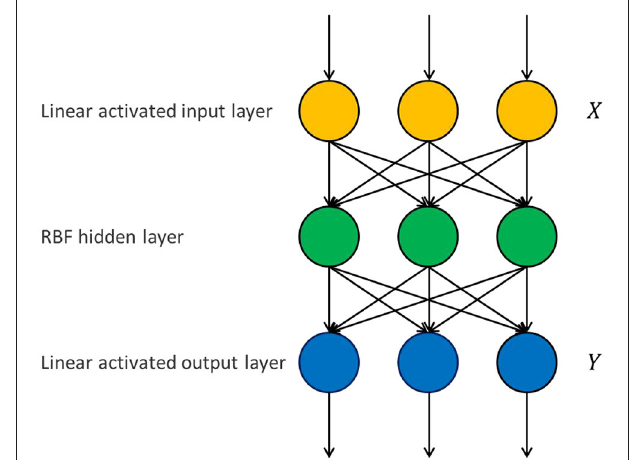
FIGURE 1 | RBFNN classifier